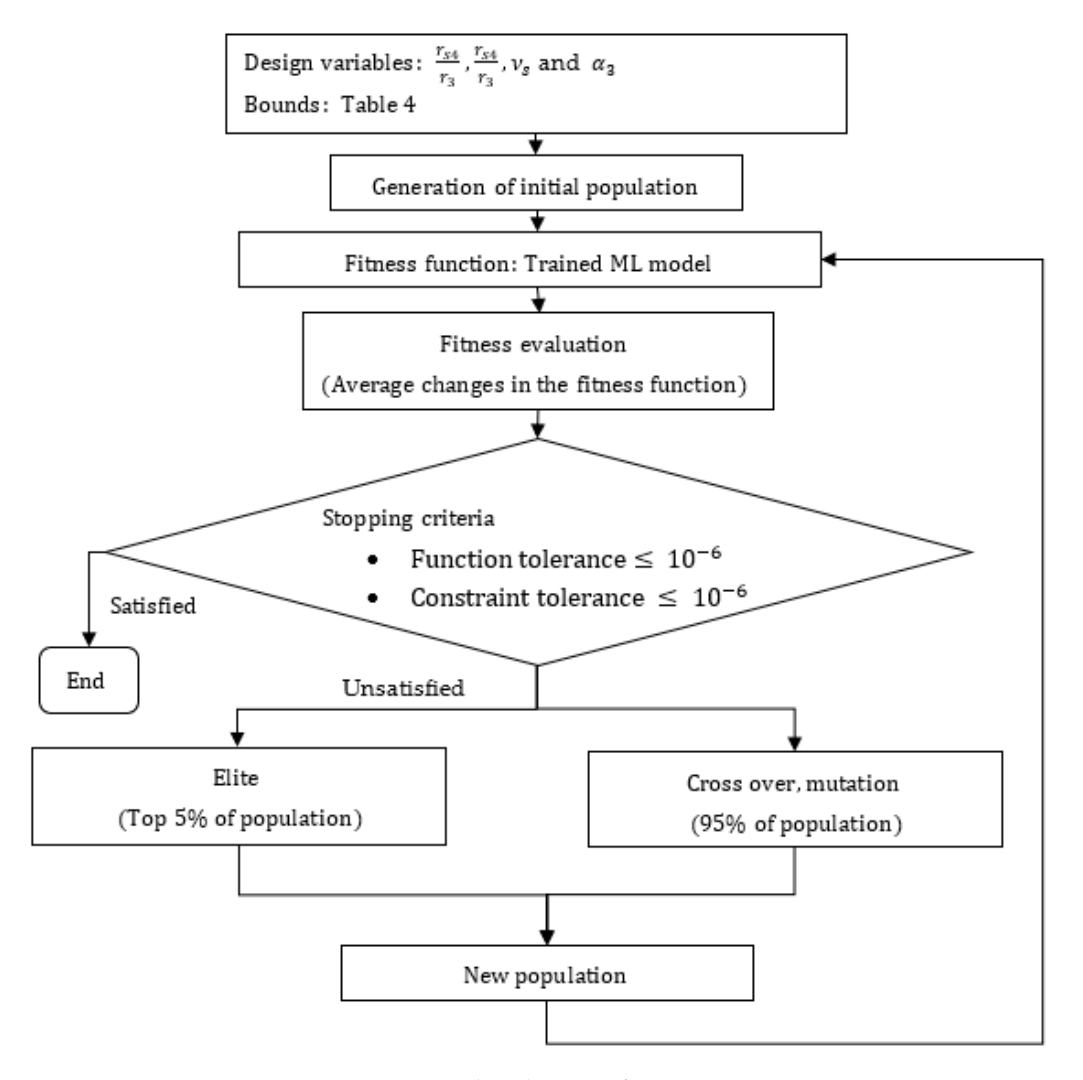
Figure 9. Flow diagram of MOGA. Table 4. Adopted limits of the design variables.